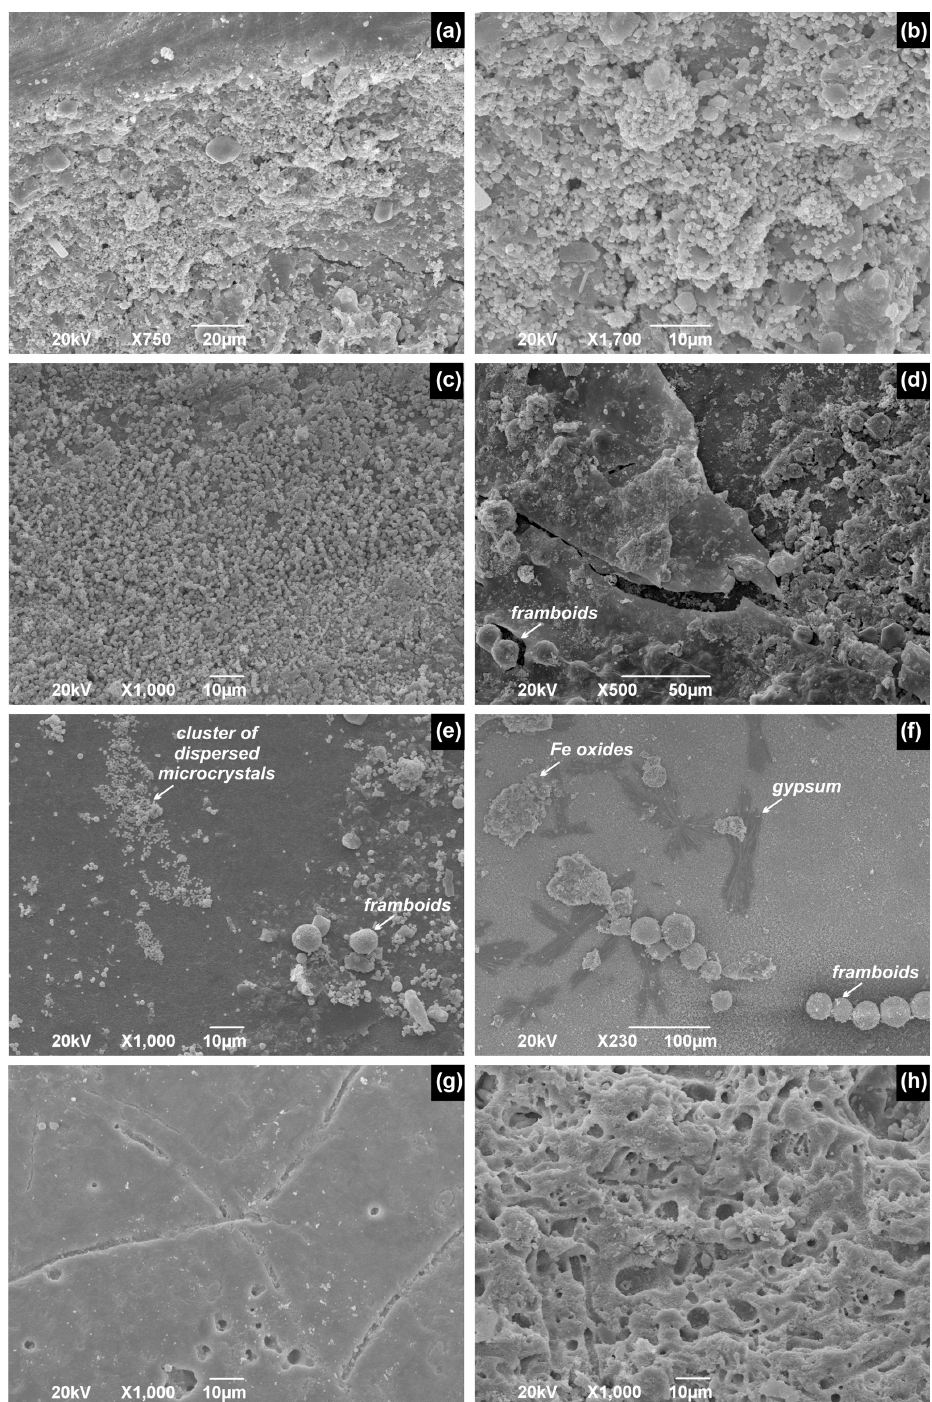
Figure 9. Internal surfaces of V. gibba with isolated and clustered framboids on well-preserved valves from Po and with intense borings on valves from Brijuni. (a–b) Dispersed pyrite microcrystals and isolated framboids clustered around the groove at which the internal conchiolin crops out. (c) Dispersed pyrite microcrystals close to the groove. (d) Sheets of organics underlain by framboids on the interior of the right valve close to the ventral margin. (e) Clusters of dispersed microcystals and isolated framboids on the well-preserved ventral valve margin. (f) Strings of pyrite framboids, irregular flakes of Fe oxides, and small gypsum crystals. Moderate (g) and strong (h) bioerosion. (a–b) Po4- 30-35cm-28. (d–f) Po4-30-35cm-28. (g) Brijuni-M44-70-75cm-3. (h)